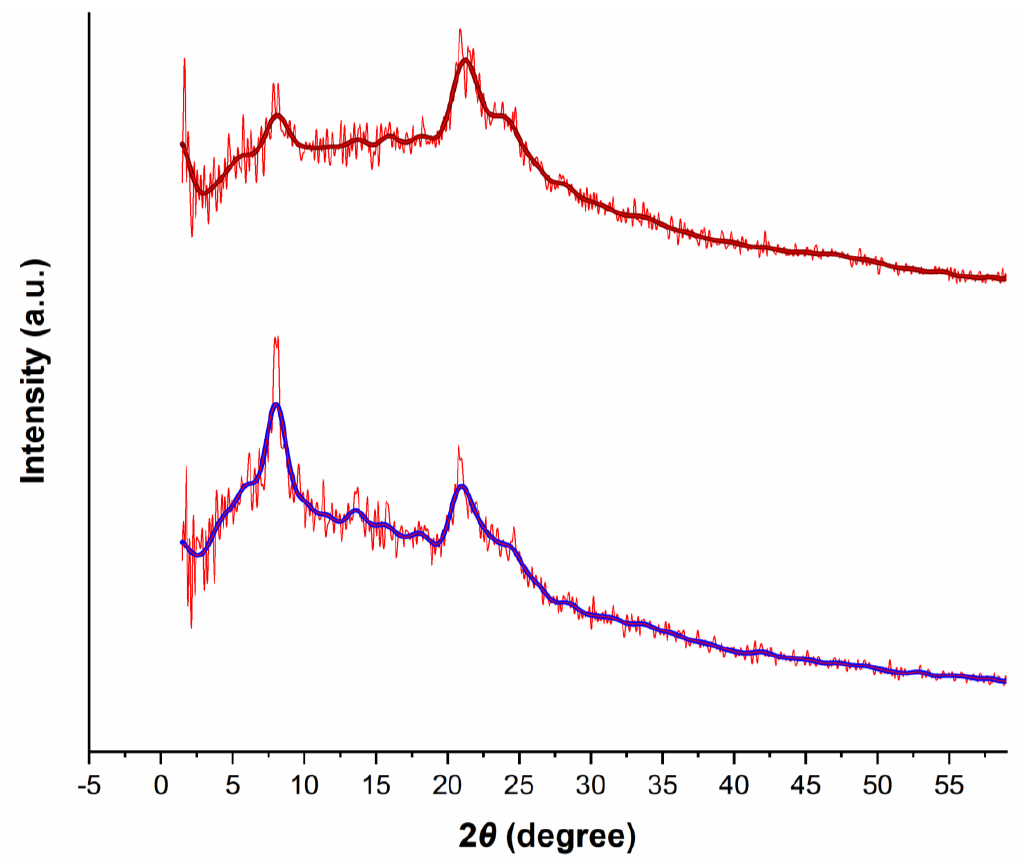
Figure 3. Powder XRD patterns of the fresh (bottom) and the reused (top) of the prepared Porph−UOZ−COF polymer.